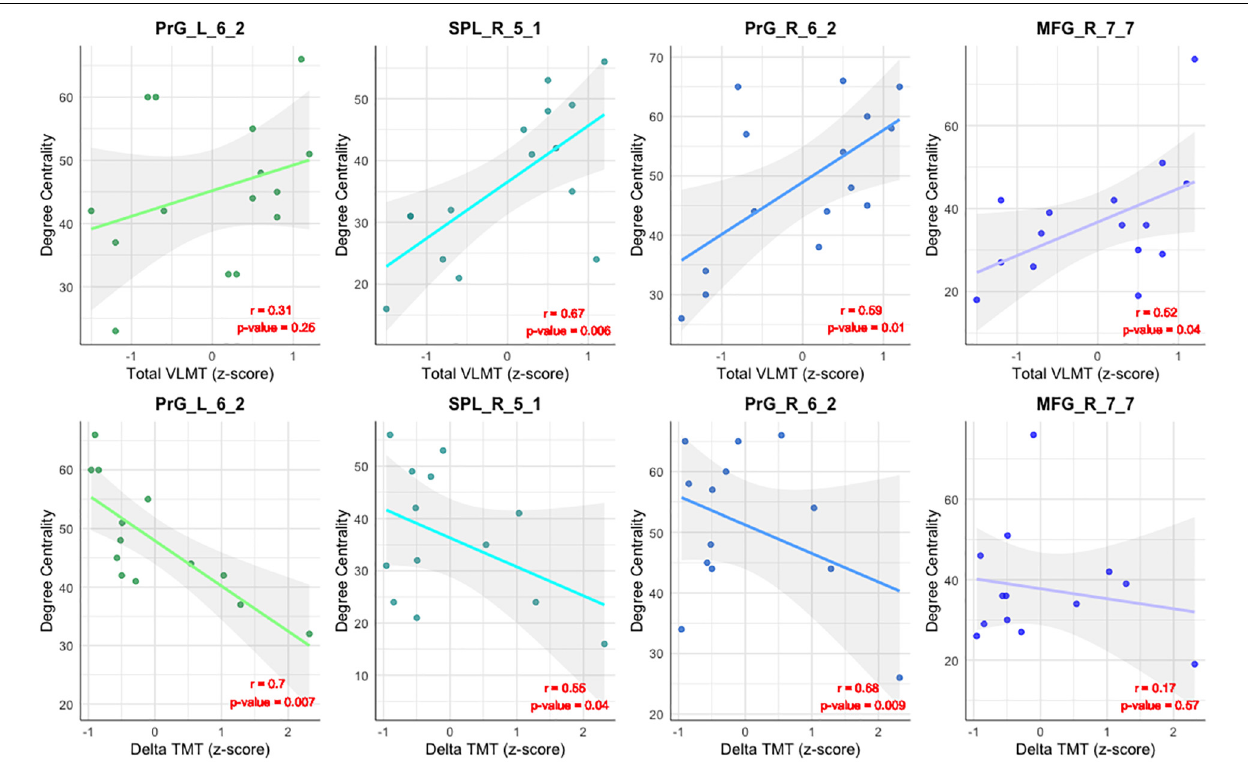
Frontiers in Aging Neuroscience |